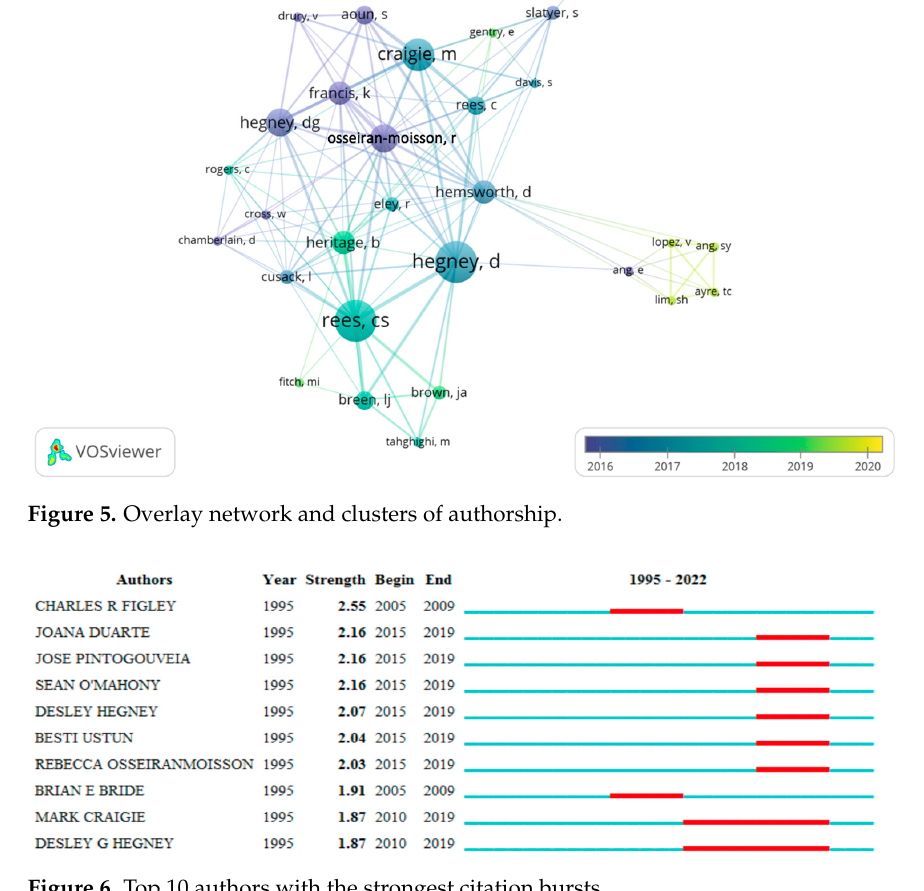
Figure 6. Top 10 authors with the strongest citation bursts.